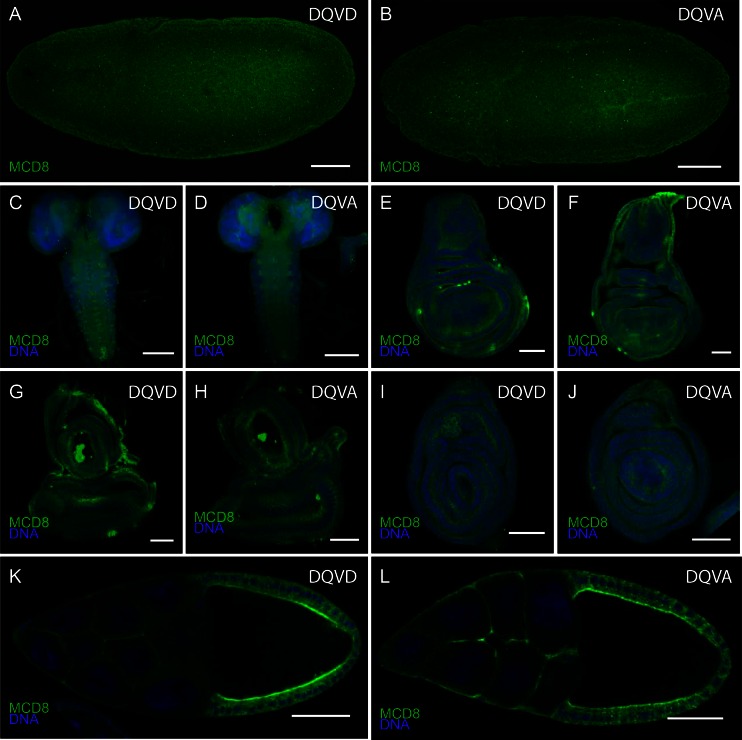
Expression of CasExpress DQVD and the DQVA control.Anti mCD8 staining of the DQVD CasExpress sensor (A, C, E, G, I, K) or DQVA caspase-insensitive control (B, D, F, H, J, L) in stage 10 embryos (A, B), and 3rd instar larval central nervous system (C, D), wing disc (E, F), eye-antennal disc (G, H) and leg disc (I, J) Stage 10 egg chambers of the adult ovary (K, L). Scale bars in A–D and K, L are 100 μm, in G–J are 50 μm.